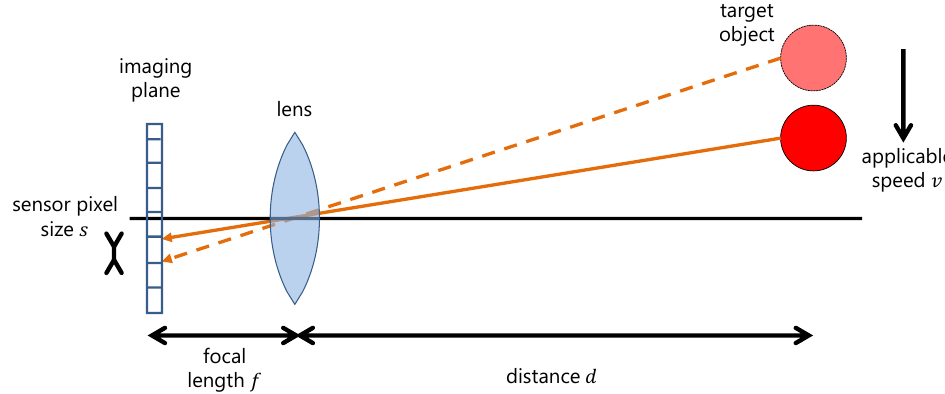
Figure 6. Relationship between object speed and the exposure time (Equation (7)). This figure means that we can ignore the difference of target object position between captured images as long as the target object is projected within the single pixel at imaging plane. This figure shows that the applicable object speed that we can ignore the difference position of moving object depends on a focal length, distance between image sensor and target object, and pixel size of image sensor.